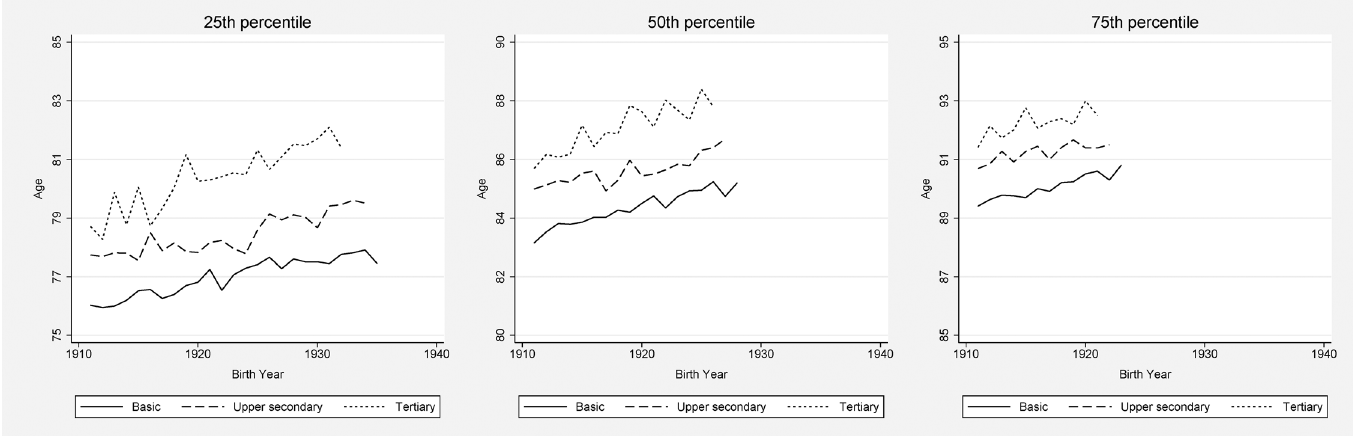
Fig 2. Survival by education, women. Age at which 25, 50 (i.e., median age of death), and 75% of the study population had